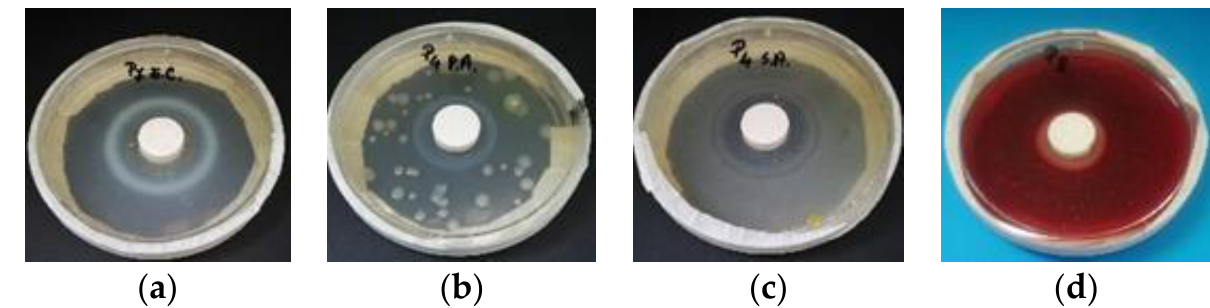
Figure 7. Nano-TiO 2 systems evaluation: ( a ) 5% TiO 2 , (14 days exposure to Escherichia coli ); ( b ) 3.6% TiO 2 (6 days exposure to Pseudomonas Aeruginosa) ; ( c ) 3% TiO 2 (14 days exposure to Staphylococcus Aureus ); ( d ) 6% TiO 2 (21 days exposure to Streptococcus Pyogenes ).